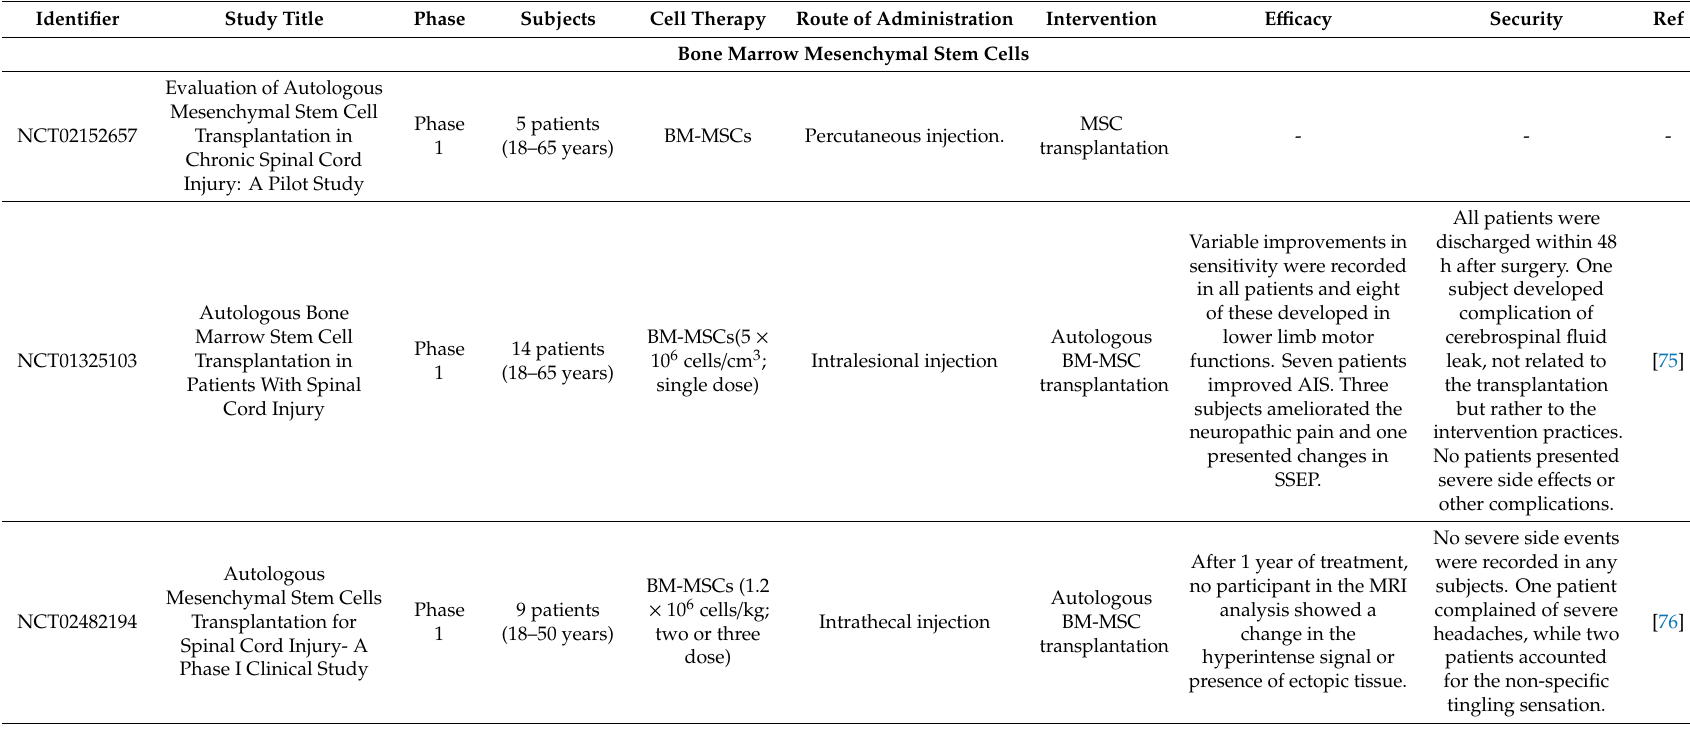
Table 1. Completed clinical trials of stem cell therapy in SCI (https: // clinicaltrials.gov / ). The table shows the e ffi cacy and safety of stem cell therapy in the management of